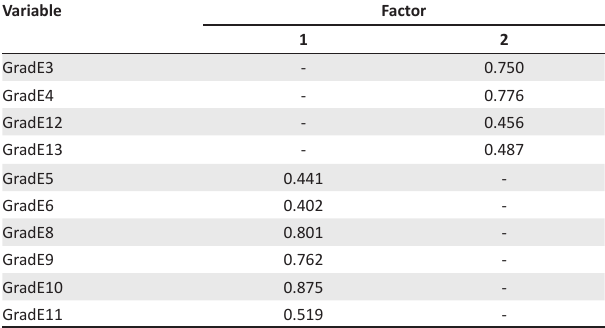
TABLE 4: Factor matrix for graduate employability items. Variable